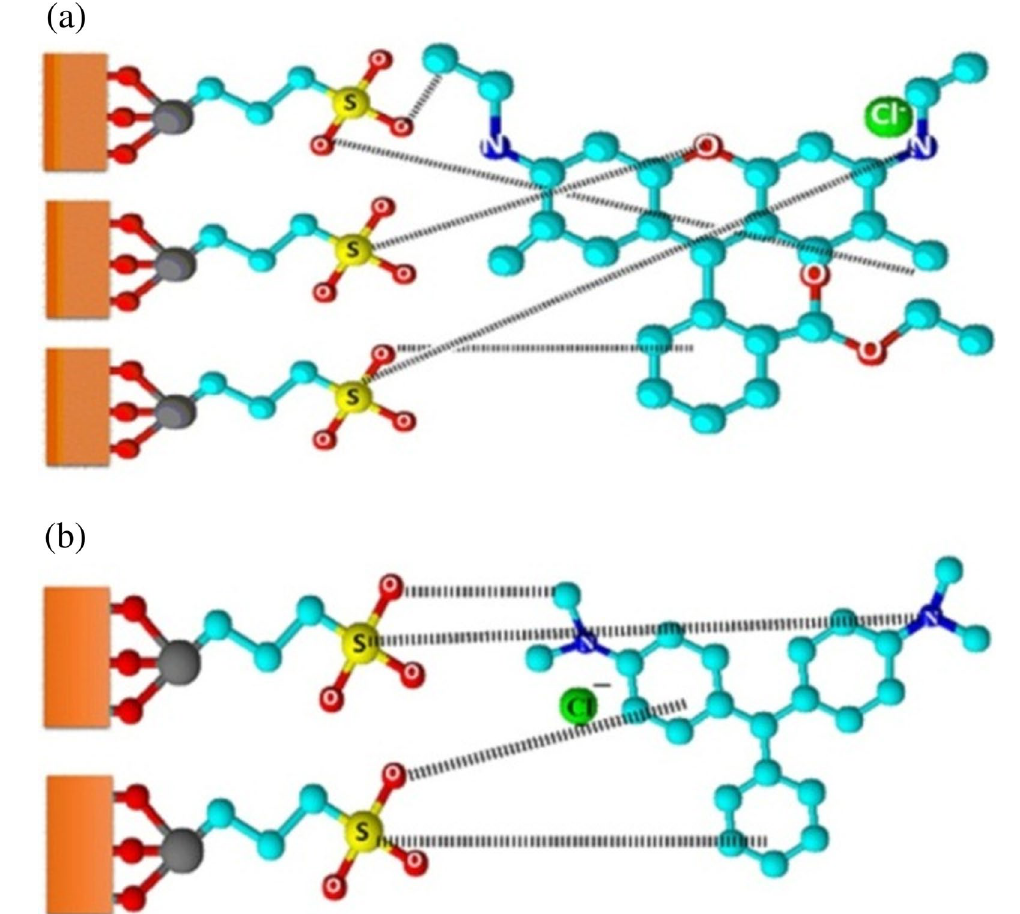
Fig. 12 Mechanism of adsorption of ( a ) R6G and ( b ) MG dyes on HATF-SO